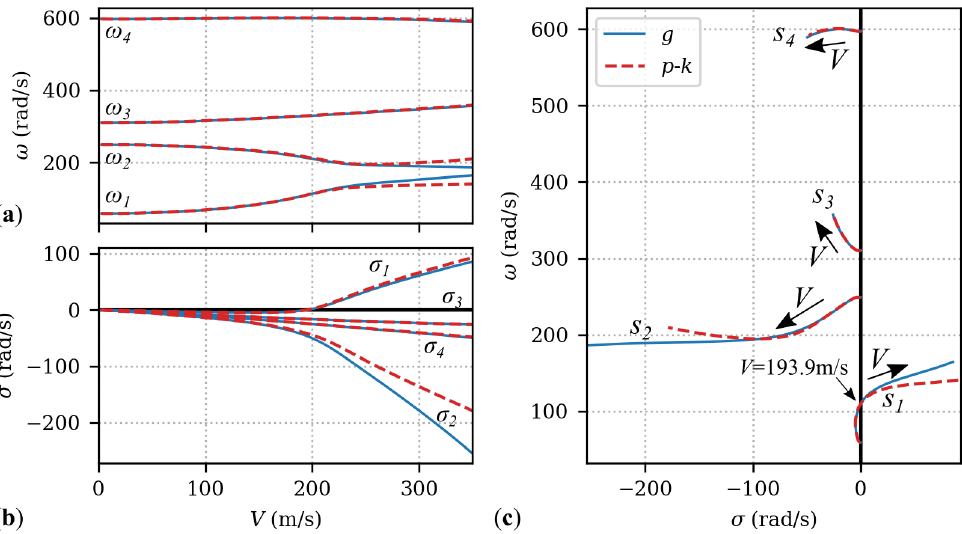
Figure 6. Eigenvalue solutions of the nonlinear aeroelastic eigenproblem for the AGARD 445.6 weakened model employing the p - k method and the g method for freestream velocities from 0 m/s to 350 m/s with the flutter onset velocity at 193.9 m/s. ( a ) Angular frequencies. ( b ) Damping coefficients. ( c ) Eigenvalues in the complex